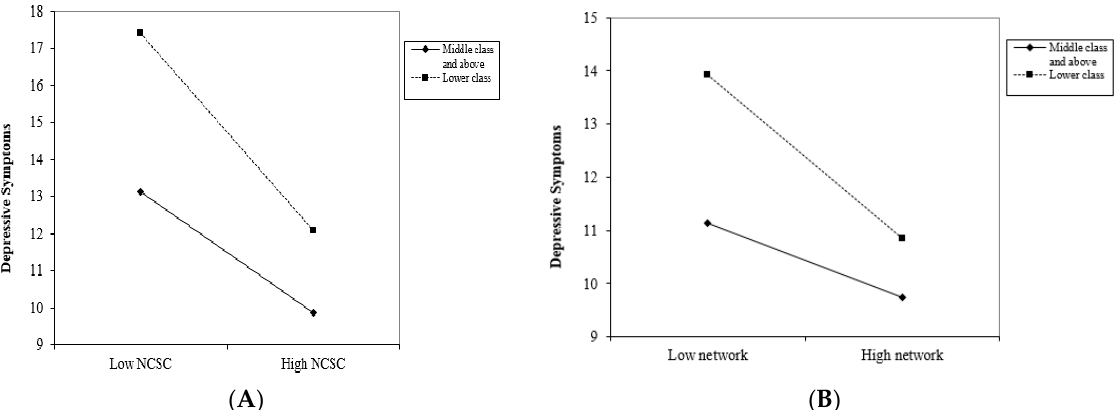
Figure 2. The relationship between discussion network and depressive symptoms varied among socioeconomic groups. ( A ) refers to the relationship between NCSC and derpessive symptoms among socioeconomic groups; ( B ) refers to the relationship between discussion network and depressive symptoms among socioeconomic groups.